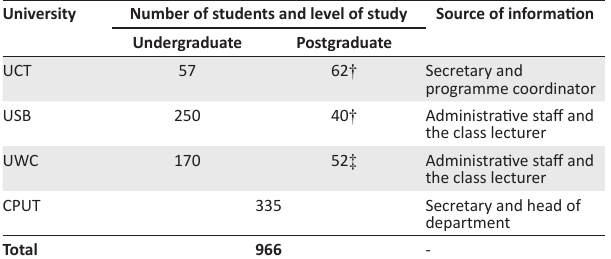
TABLE 1: Determination of the